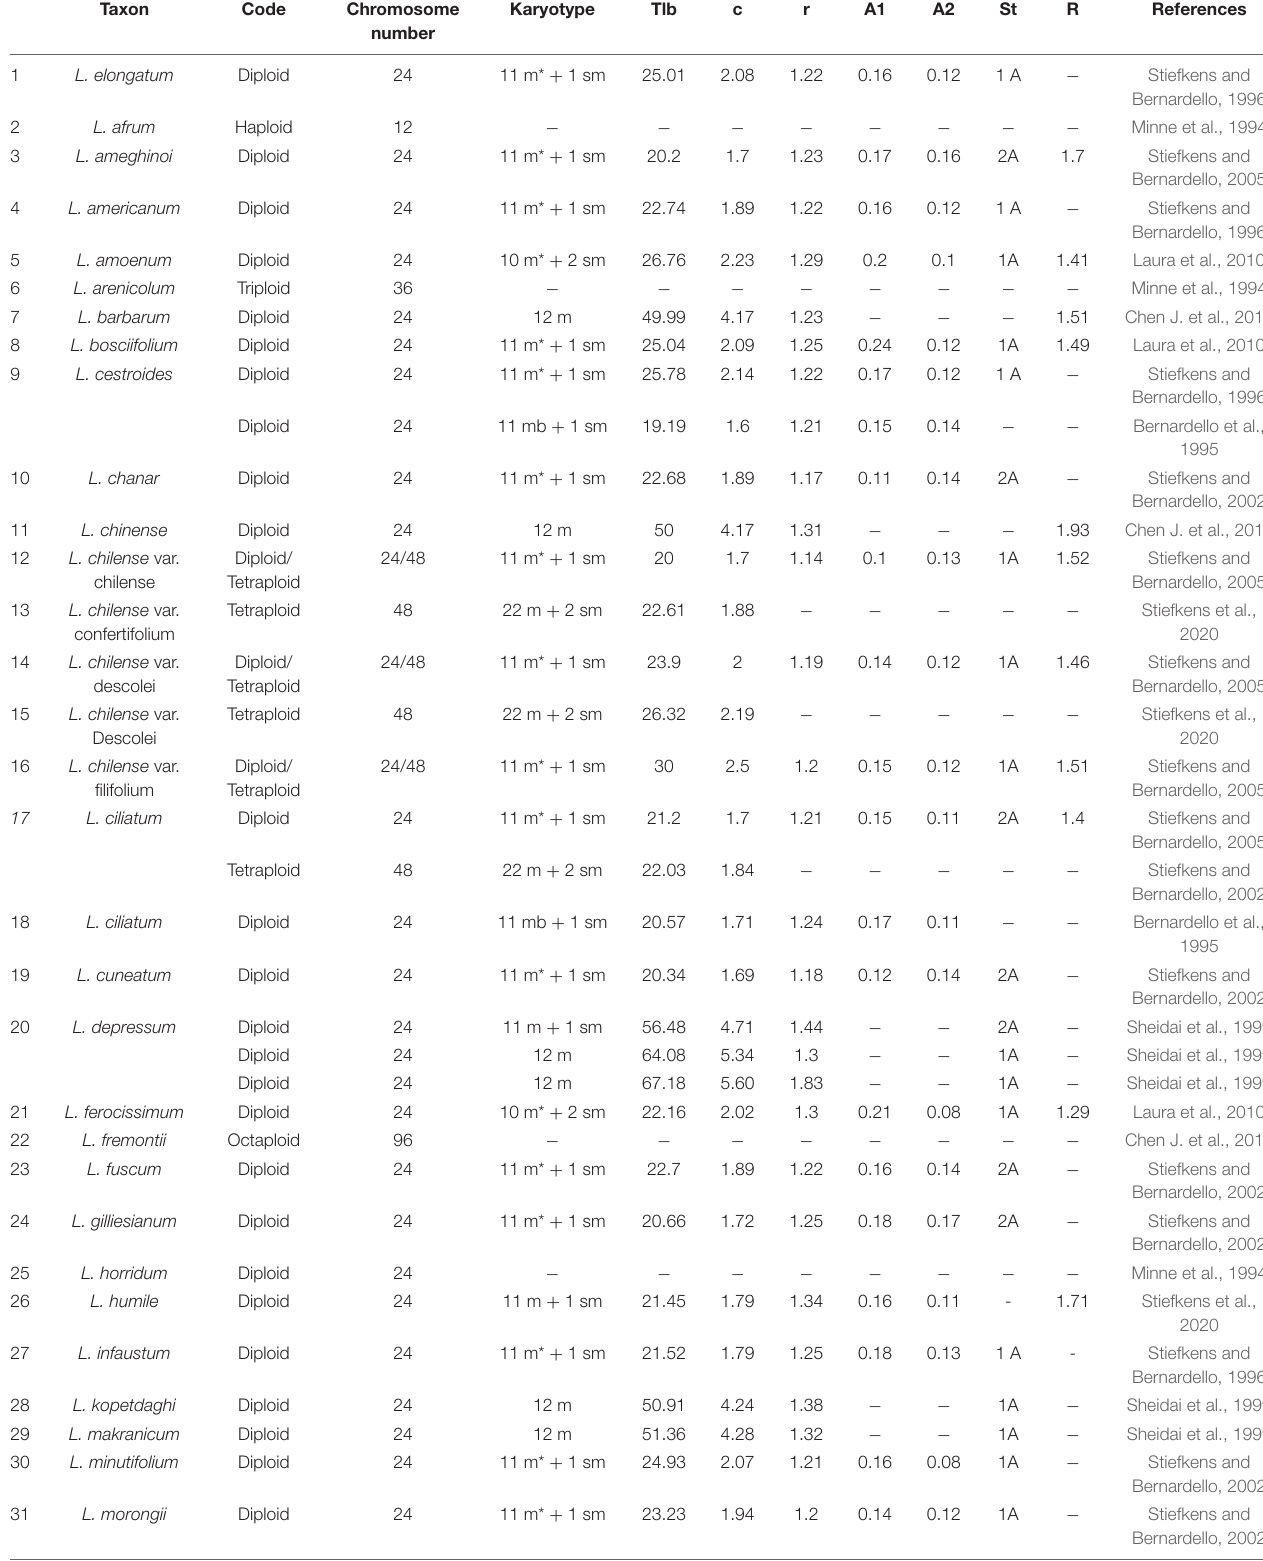
TABLE 1 | Cytological characteristics of Lycium